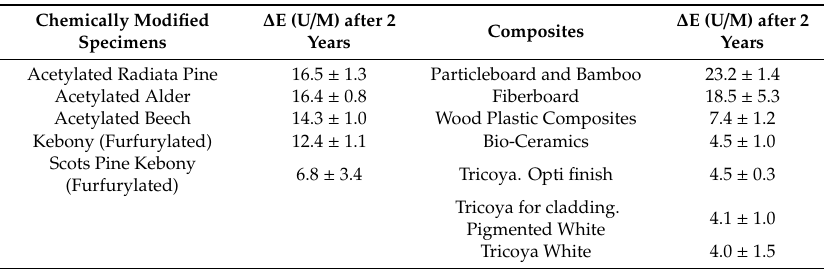
Table 2. Colour change of chemically modified and composite specimens.